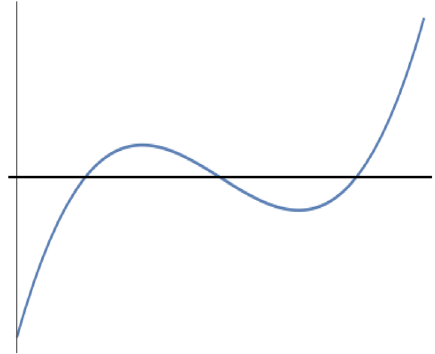
Figure 1. Cubic polynomial.